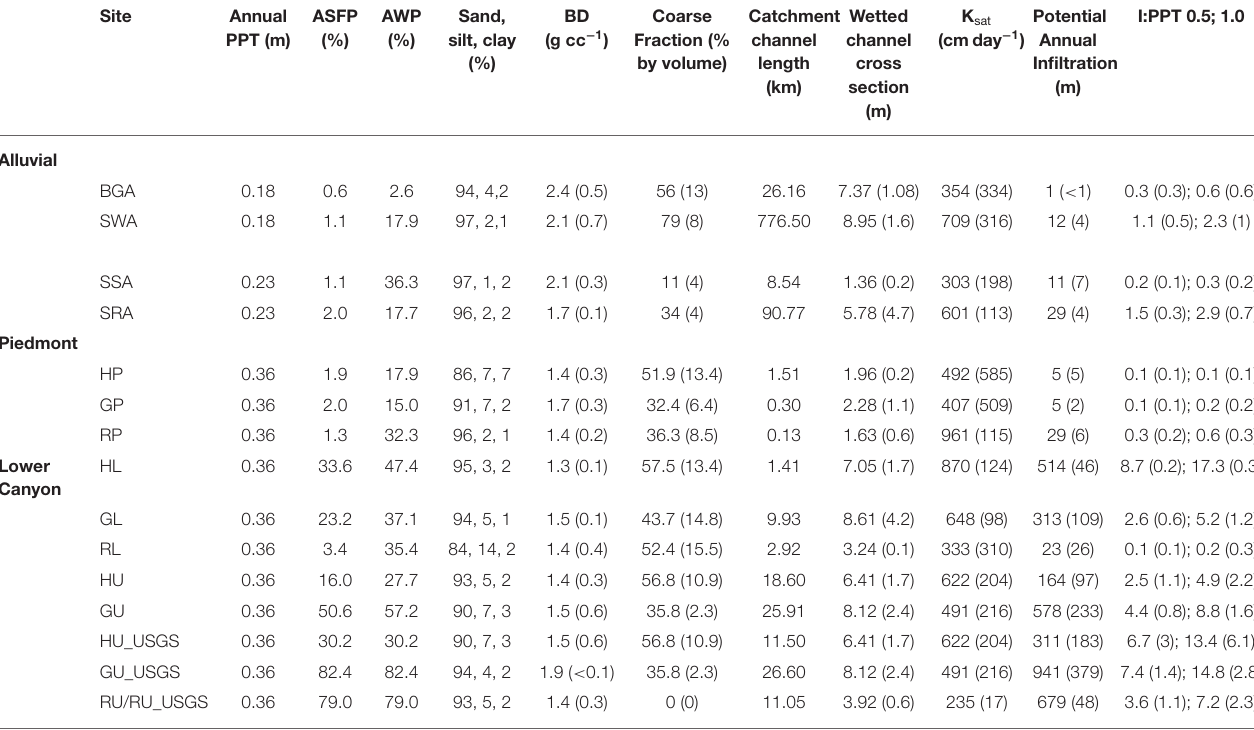
TABLE 2 | Annual precipitation (PPT), percent annual streamflow presence (ASFP), percent annual water presence (AWP), and stream substrate characteristics including bulk density (BD) and coarse fraction by volume (%) at each monitoring reach.